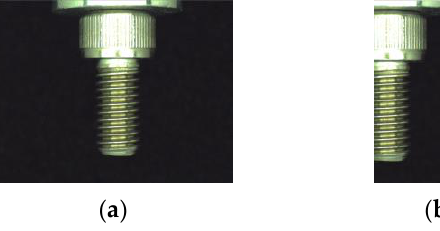
Figure 6. The schematic diagram of the template matching approach (unit: 0.03 mm/pixel). ( a ) Source image; ( b ) template image; ( c ) the detective region of the template in the source image.